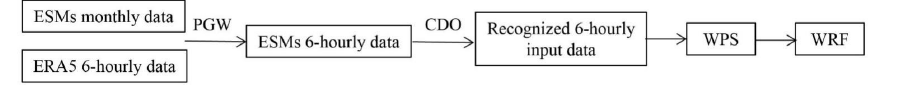
Figure 2. The WRF flow chart. PGW refers to the pseudo global warming downscaling method, and CDOs refer to Climate Data Operators used for generating the WRF recognisable “GRIB” format input data. WPS is the WRF Preprocessing